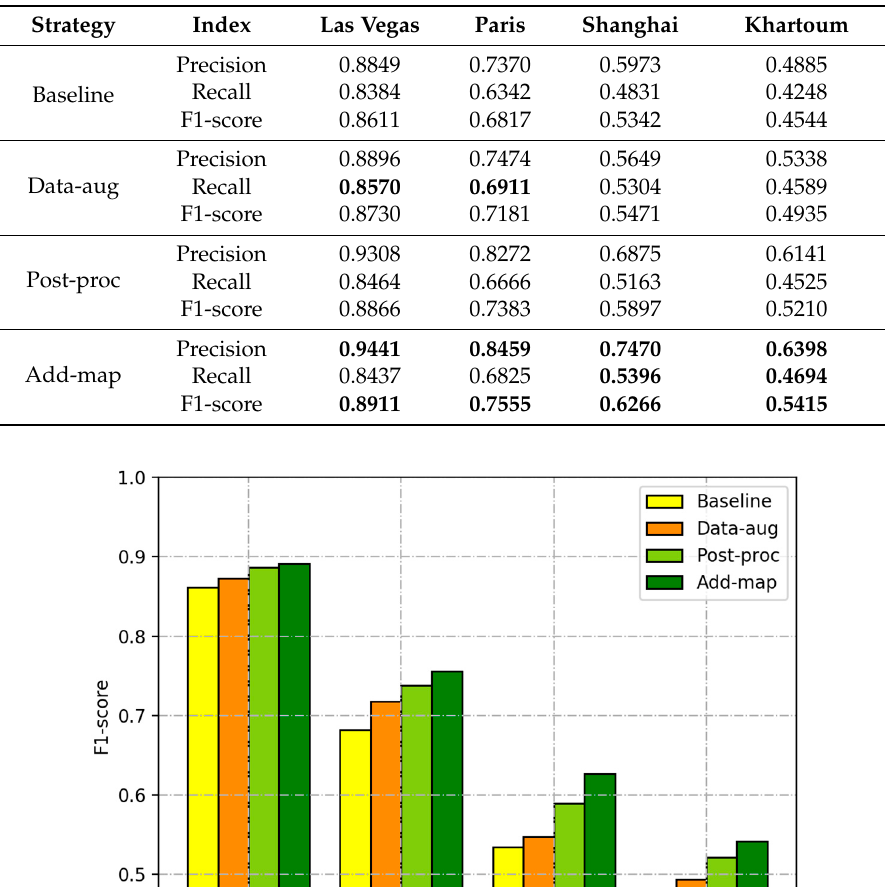
Table 7. Results obtained after applying different strategies of our proposed method.